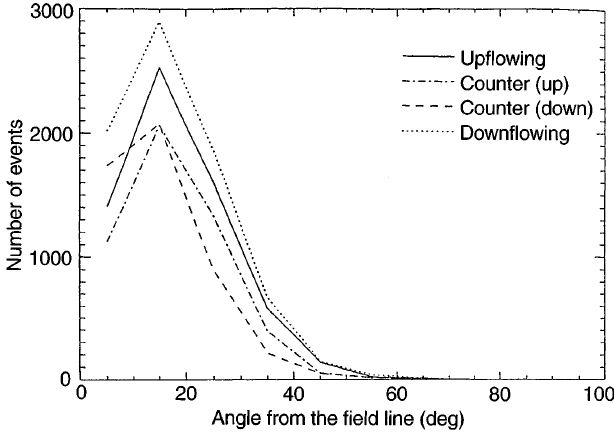
Fig. 2. Angular distribution of the electron beams associated with upflowing ion events. The electron beams are divided into the four types as indicated in the figure